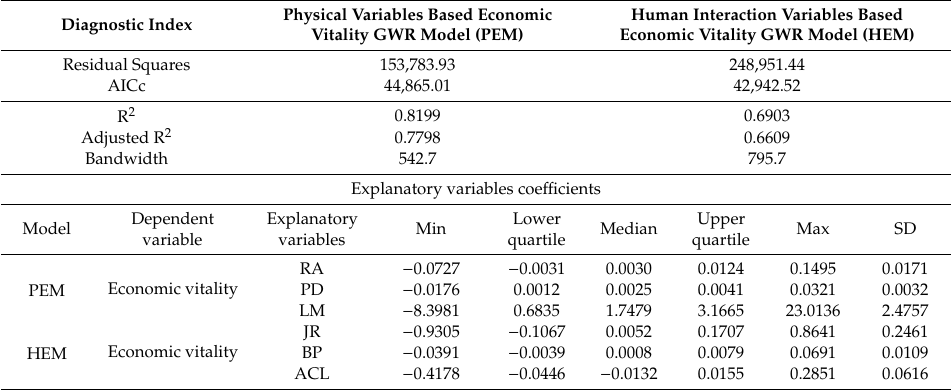
Table 6. GWR modeling results for economic vitality and driving